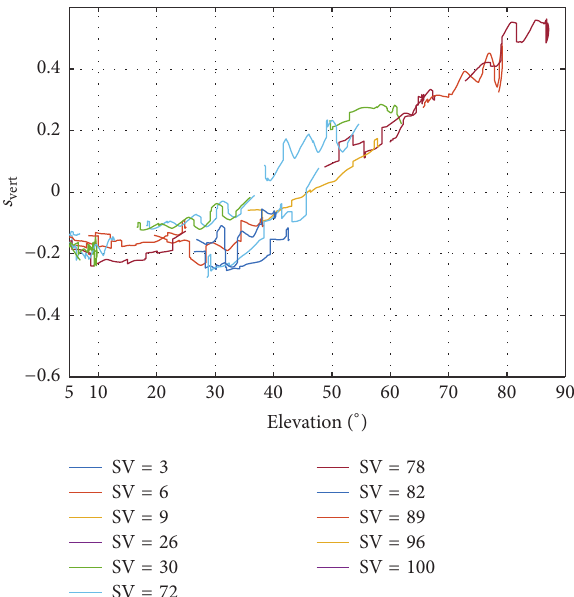
Figure 3: 𝑠 as a function of the elevation of the satellites for a vert future combined GPS (SVs 1–32)/Galileo (SVs 71–100) constellation with 31 and 27 satellites,